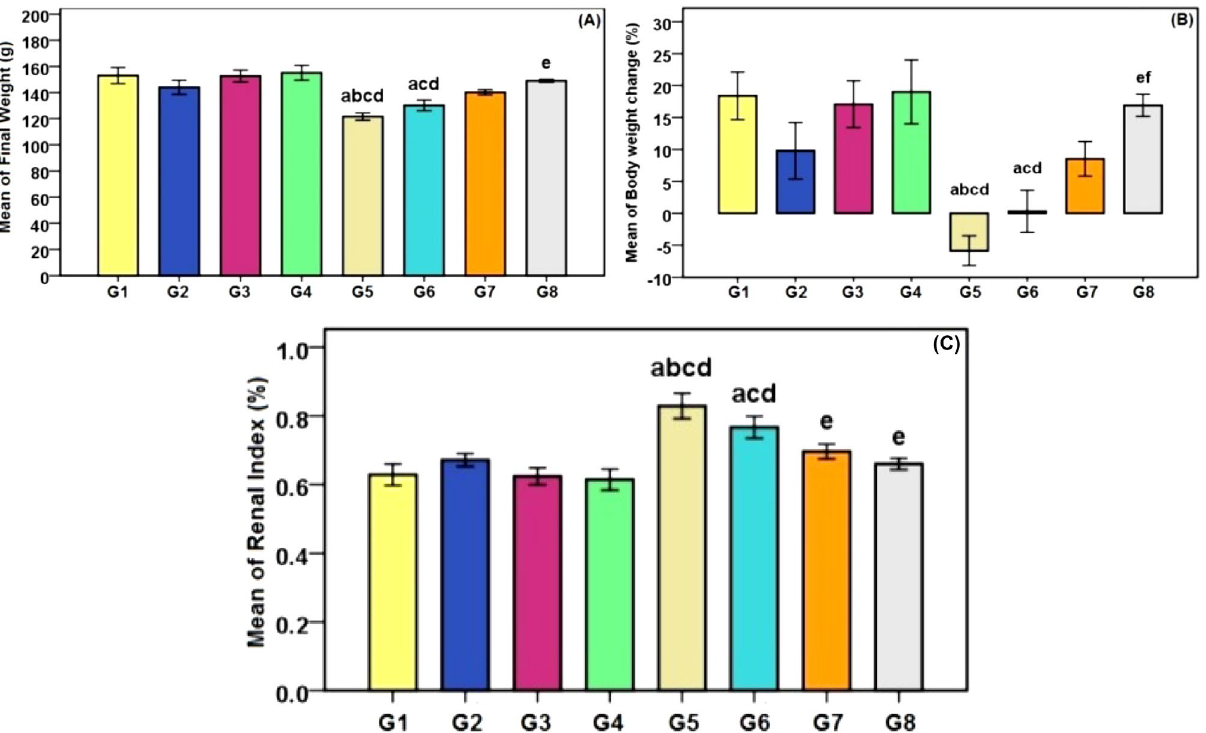
Figure 3. The effect of different treatments in CDDP-induced nephrotoxicity on ( A ) kidney weight of rats ( B ) body weight change (%) of rats, and ( C ) renal index of rats in experimental groups. G1, Control; G2, GA; G3, CMCS; G4, GA@CMCS; G5, CDDP; G6, CDDP + GA; G7, CDDP + CMCS; G8, CDDP + GA@CMCS. Values are means ± SE ( n = 8). Data were analyzed by a one-way ANOVA test followed by Tukey’s post hoc test for multiple comparisons. a p < 0.001 versus control group (G1), b p < 0.001 vs. GA (G2), c p < 0.001 vs. CMLMWC group (G3), d p < 0.001 vs. GA@CMCS group (G4). e p < 0.001 versus the CDDP group (G5), f p < 0.001 versus the (CDDP + GA) group